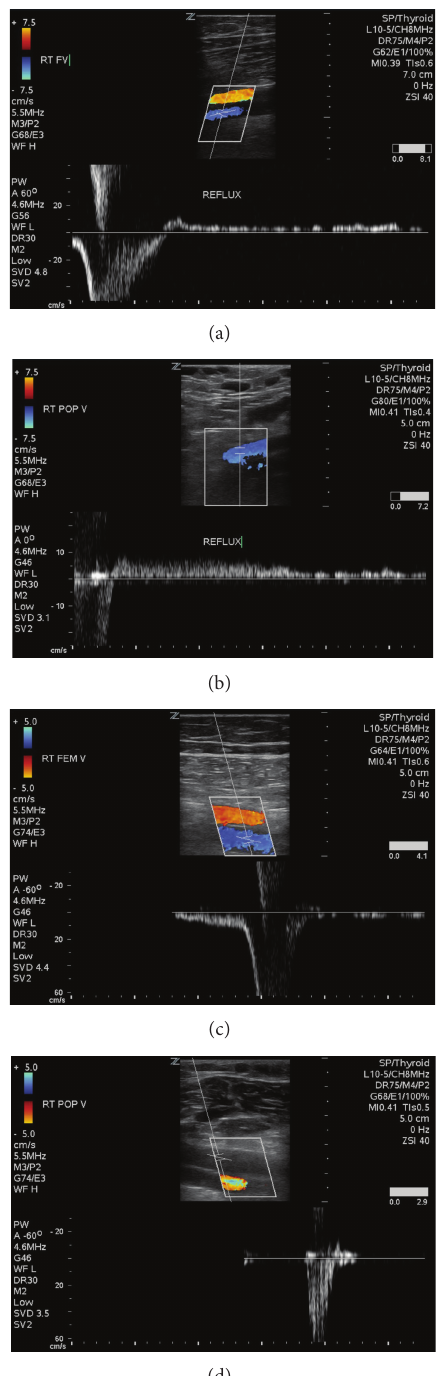
Figure 3: Pre procedure Duplex of the right femoral v. (a) and right popliteal v. (b); Post procedure Duplex of the right femoral v. (c) and right popliteal v.